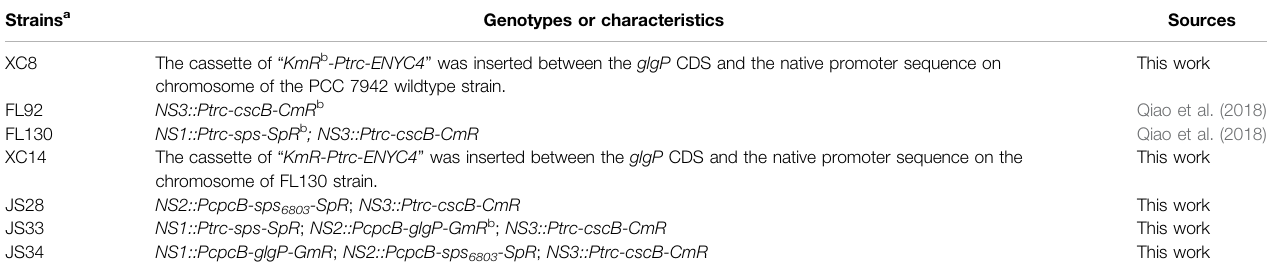
TABLE 1 | Strain constructed and utilized in this